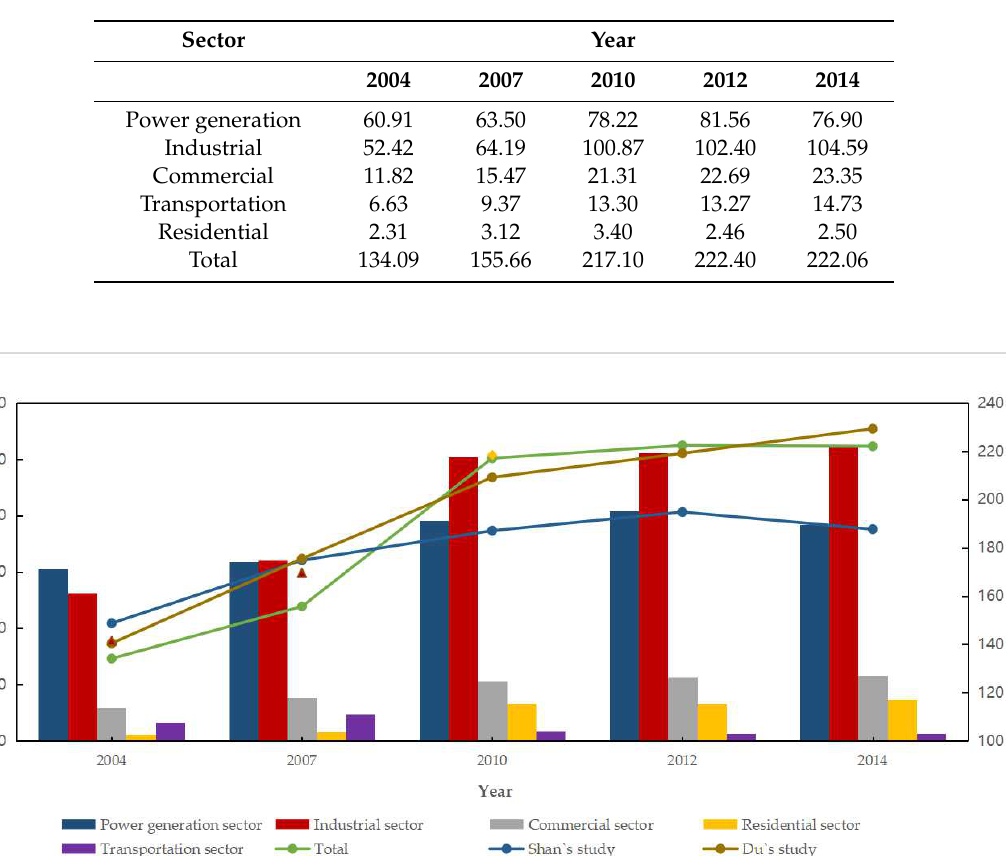
Table 2. The results of carbon dioxide emission based on a historical scenario (unit: Mt).